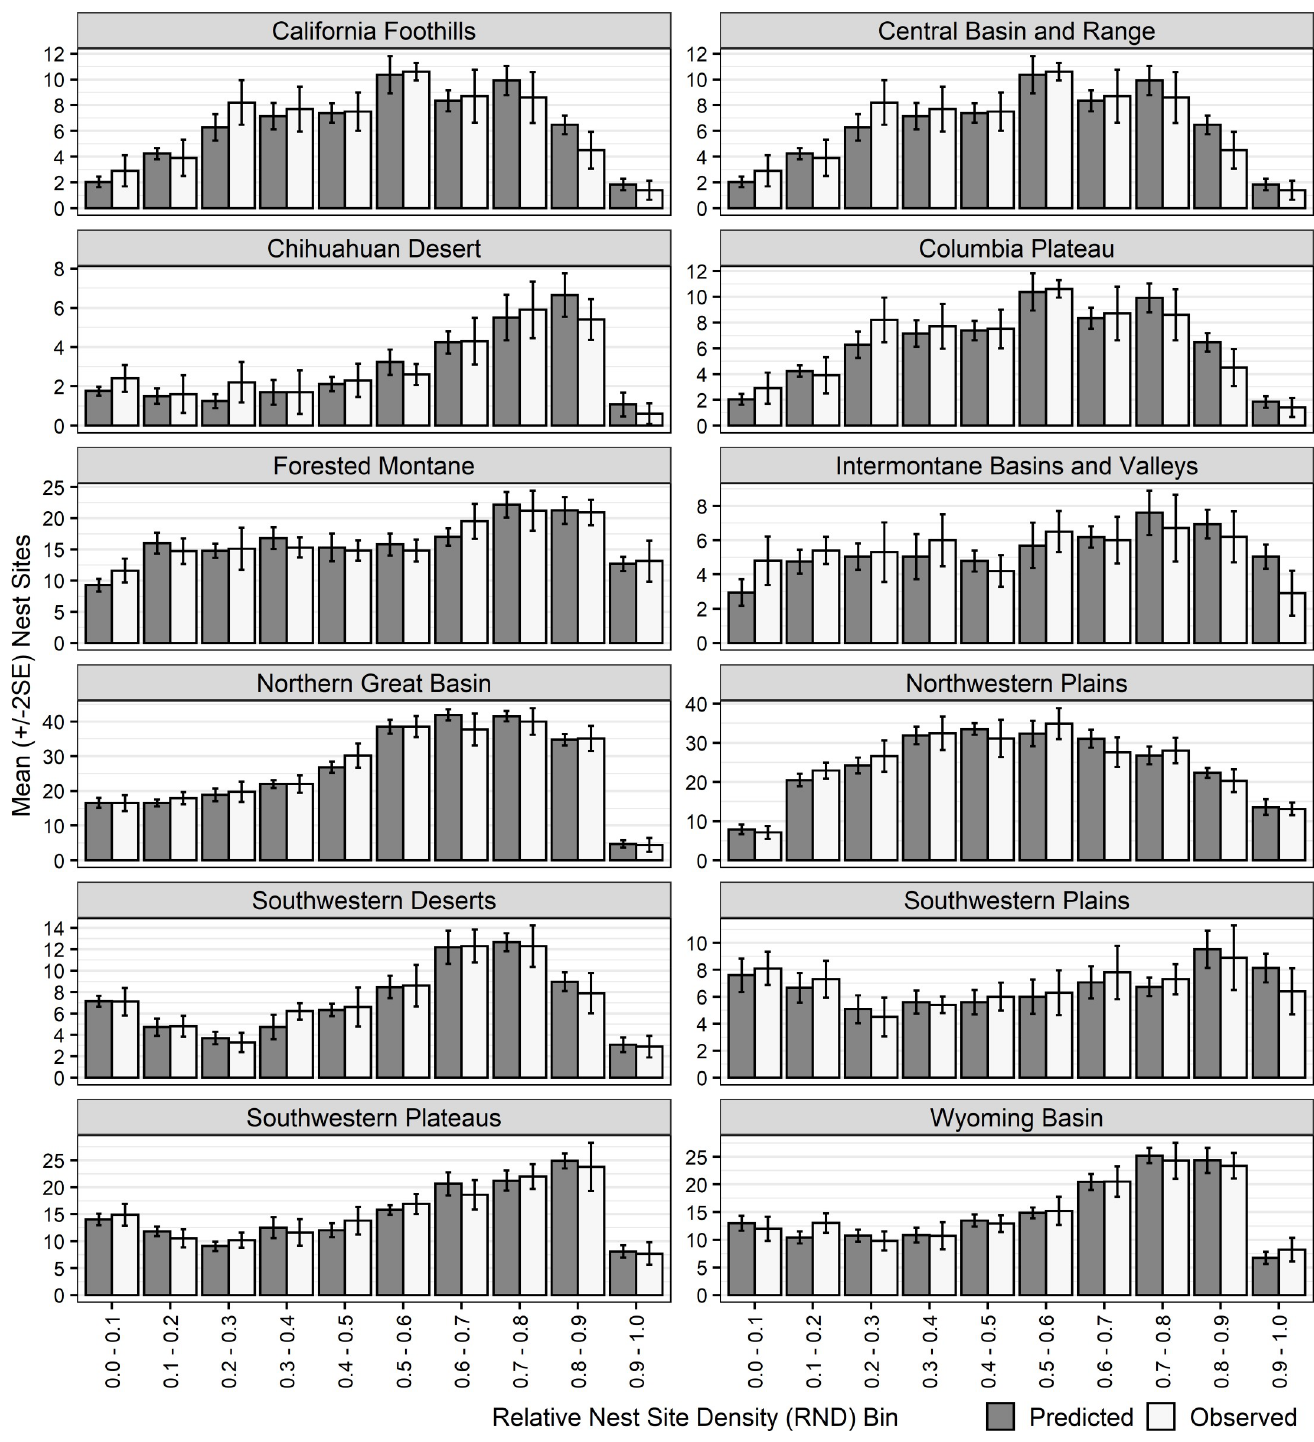
Fig 2. Bar graphs of mean ( ± 2SE) predicted and observed number of golden eagle nest sites in each of 10 relative nest density (RND) bins within each modeling region. Both predicted and observed numbers were from the 25% withheld data from 10 cross-validations of each region’s model.